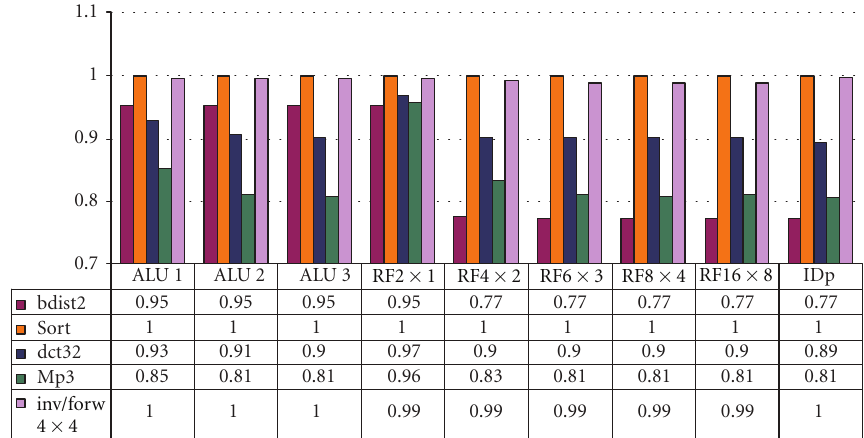
Figure 9: Relative number of execution cycles on pipelined data paths generated for di ff erent resource constraints.